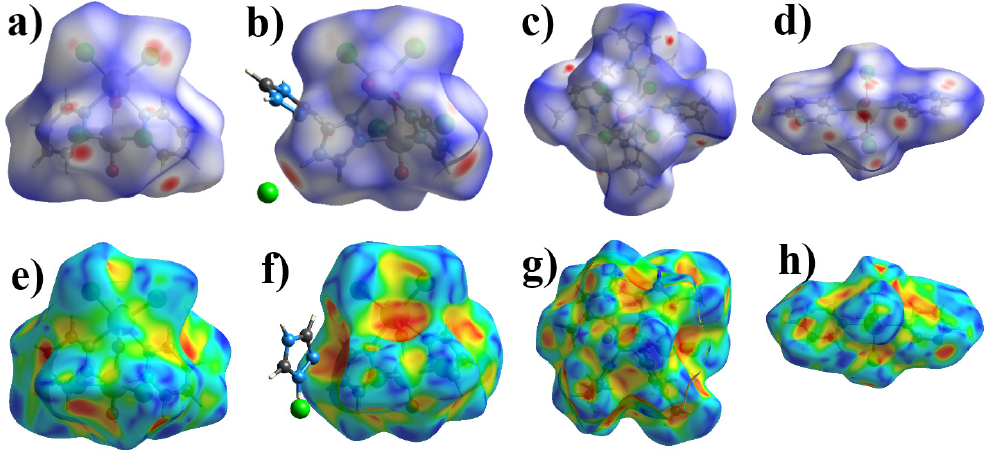
Figure 4. HS mapper over d norm for 1 ( a ), 2 ( b ), 3 ( c ) and 4 ( d ) and HS mapper shape-index of 1 ( e ), 2 ( f ), 3 ( g ), and 4 ( h ) to visualize of intermolecular interactions in crystals.